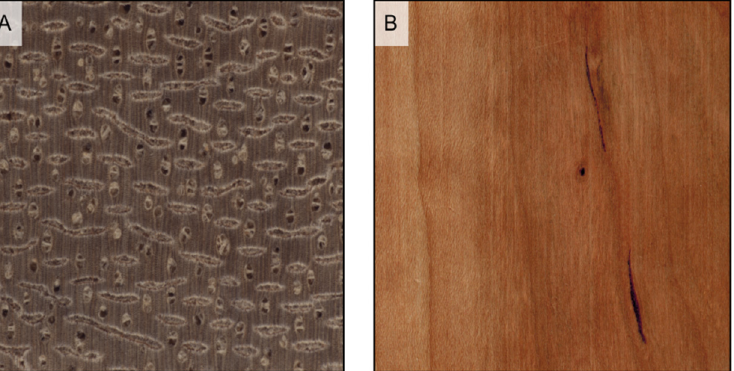
Figure 20. Diffuse included phloem on Aquilaria malaccensis (( A ) transverse section) and pith flecks on Prunus serotina (( B ) longitudinal section).